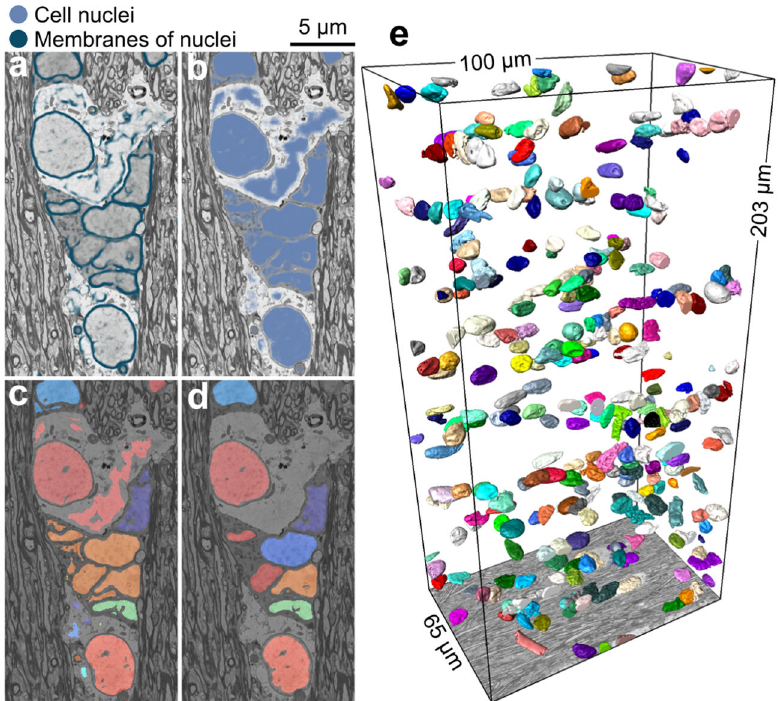
Fig. 4 DeepACSON segmentation of cell nuclei. a , b The probability maps of cell nuclei and their membrane were returned from DCNN-cN and overlaid on their corresponding BM4D fi ltered images. c The initial segmentation of cell nuclei contained topological errors as the membrane of cell nuclei exhibited discontinuity. d We recti fi ed the segmentation of cell nuclei in a GDM framework and excluded non-nucleus instances by an SVM with a quadratic kernel. e 3D rendering of cell nuclei in the contralateral corpus callosum and cingulum of sham # 25